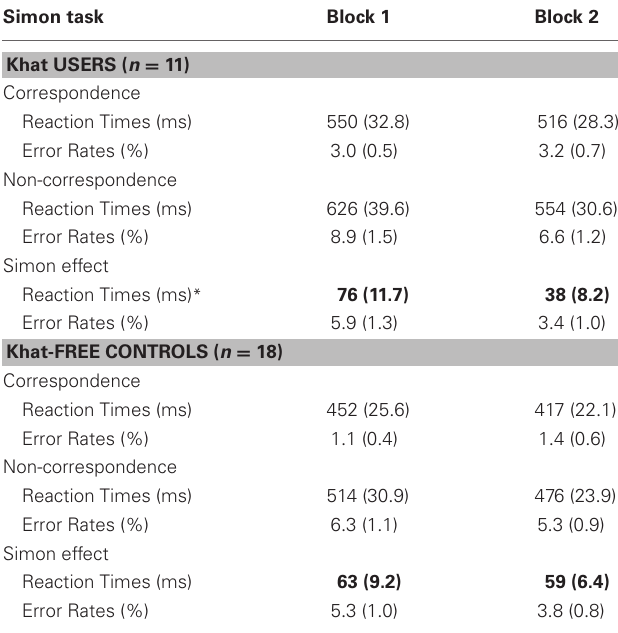
Table 3 | Performance on the Simon task as a function of block (1 vs. 2), correspondence (correspondent vs. non-correspondent) and group (khat users vs. khat-free